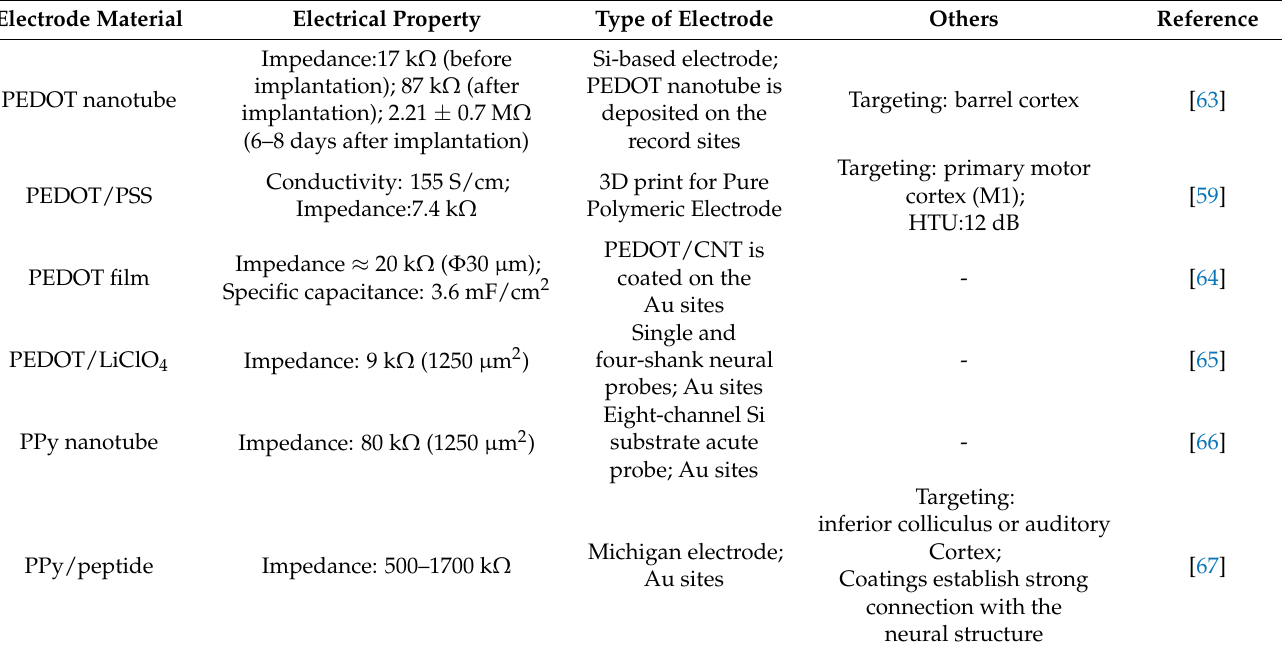
Table 1. A summary of various electrodes based on the electrode